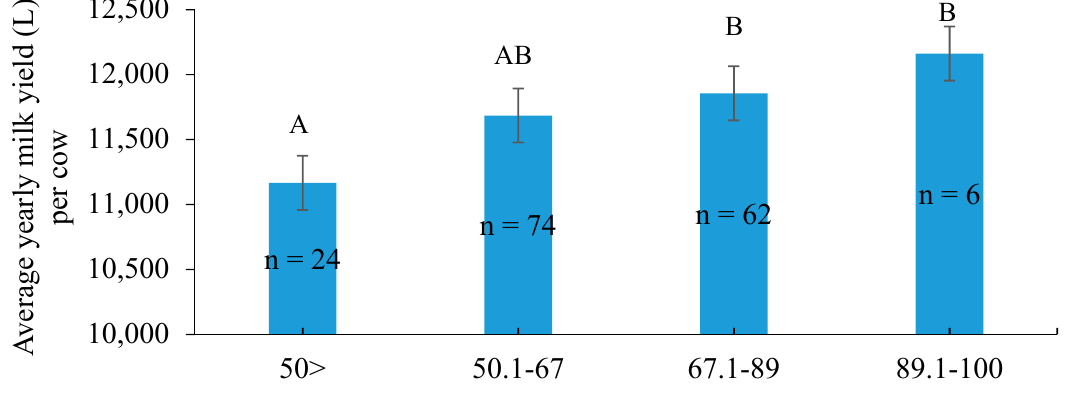
Figure 6. Effect of farm welfare assessment score (FWAS) on milk yield (corrected to 305 days) on Israeli dairy farms ( n =